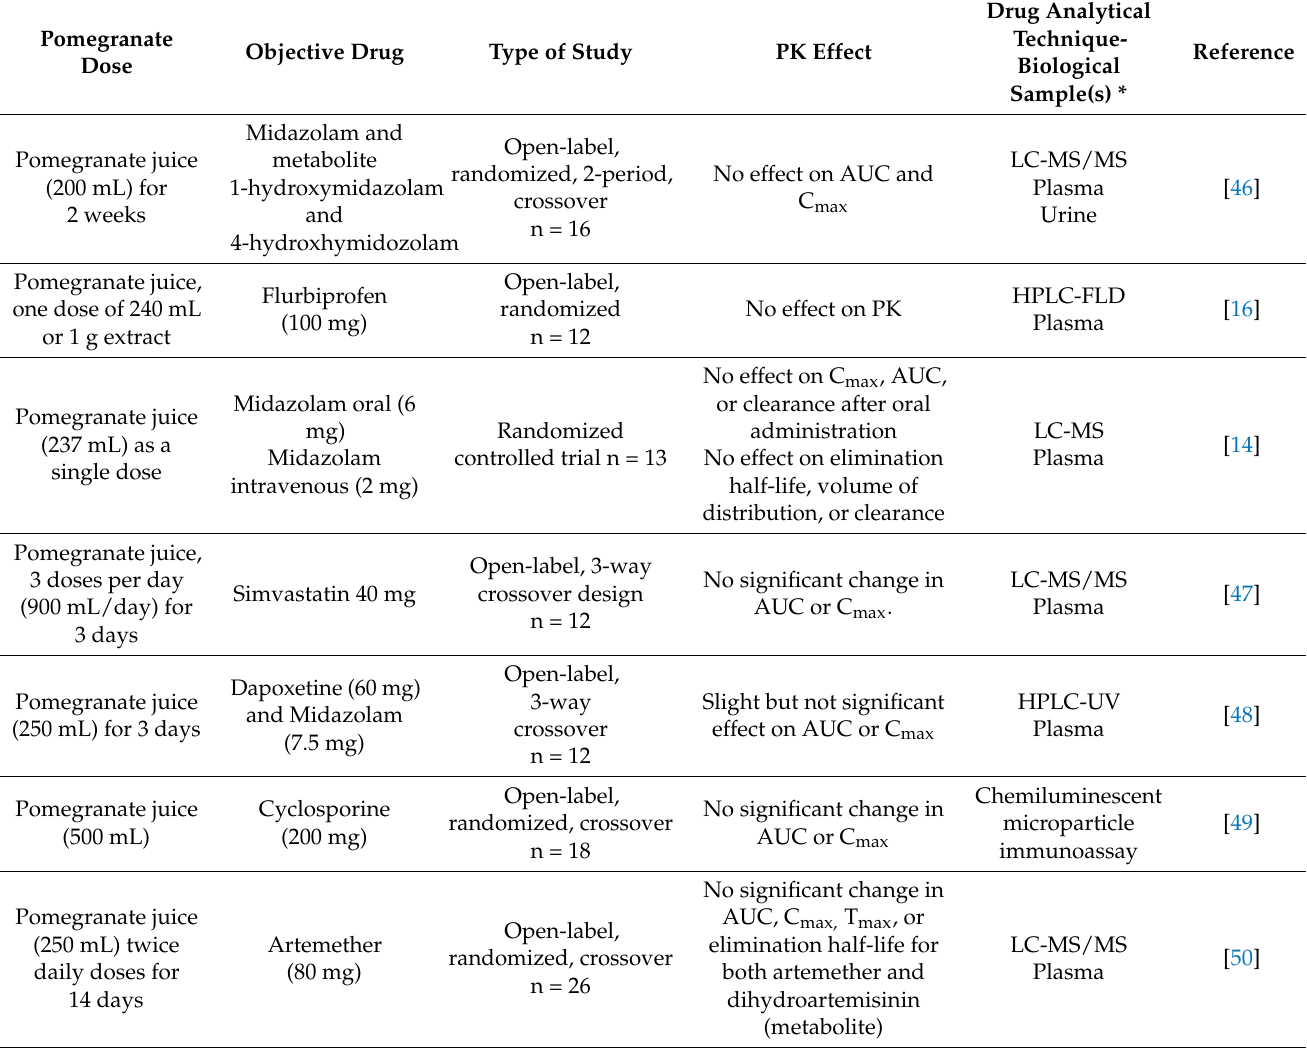
Table 3. Clinical studies investigating the effect of oral administration of pomegranate juice on the pharmacokinetics of CYP3A4 and CYP2C9-mediated